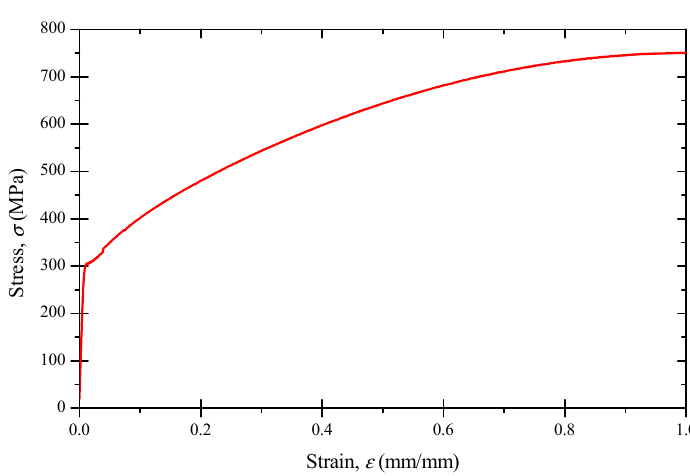
Figure 1. SEM morphology of microstructure.